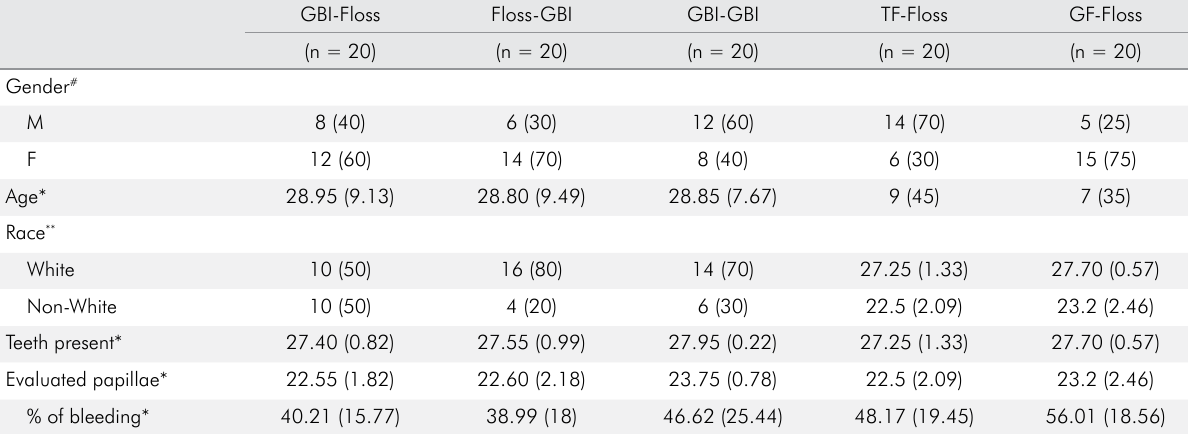
Table 1. Subject characteristics across the five evaluation